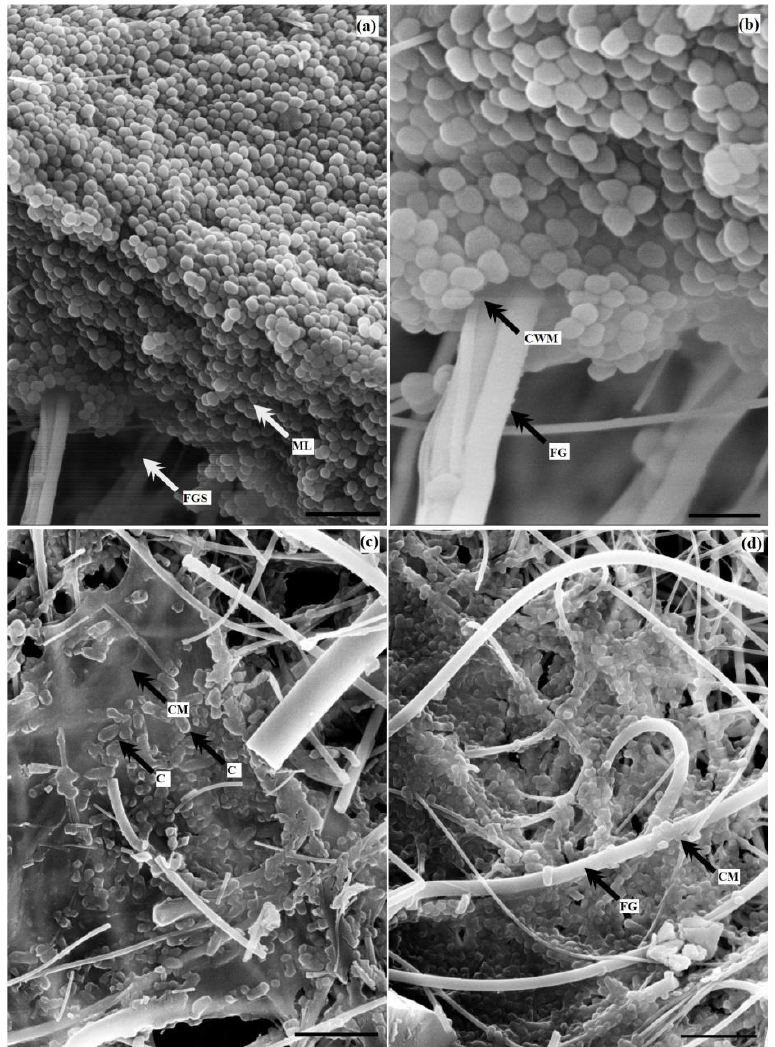
Figure 7. Overall appearance of the mono-species biofilms of K. rhizophila ( a , b ) and S. typhimurium ( c , d ) on the sixth day of incubation. Scanning electron microscopy (SEM). FGS, fiberglass substrate; ML, multicellular layer; CWM, cells without matrix; FG, fiberglass; C, cells; CM, cellular matrix. Bars, 5 µm ( a , c , d ); 2 µm ( b ).